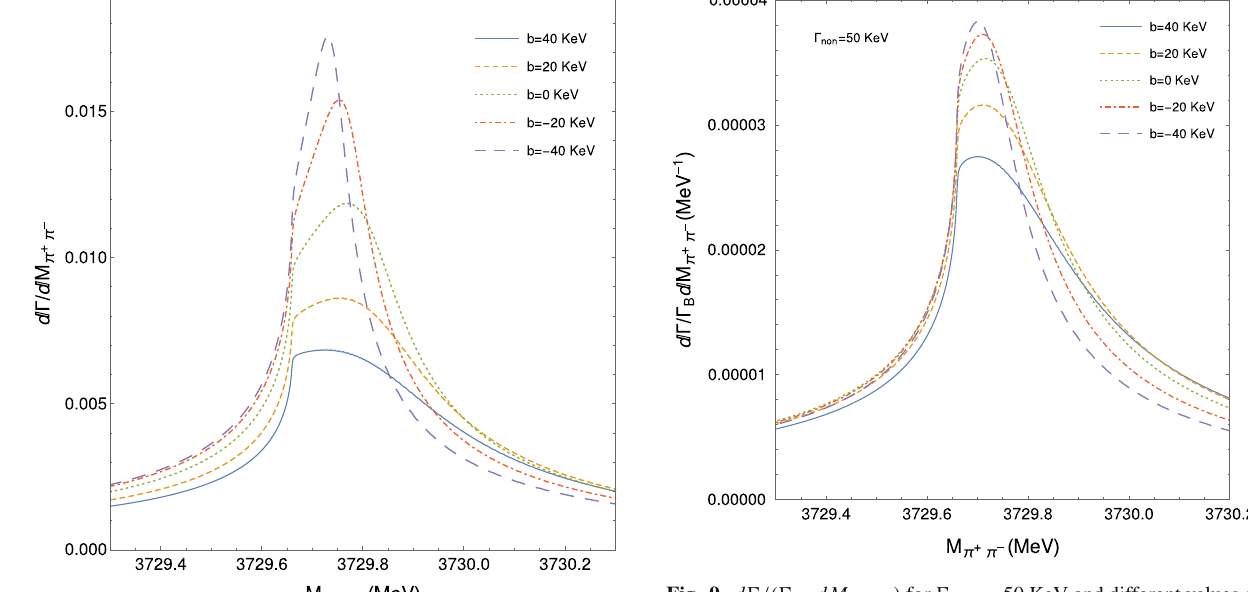
Fig. 9 d (cid:9)/((cid:9) B − dM π + π − ) for (cid:9) non = 50 KeV and different values of b = m